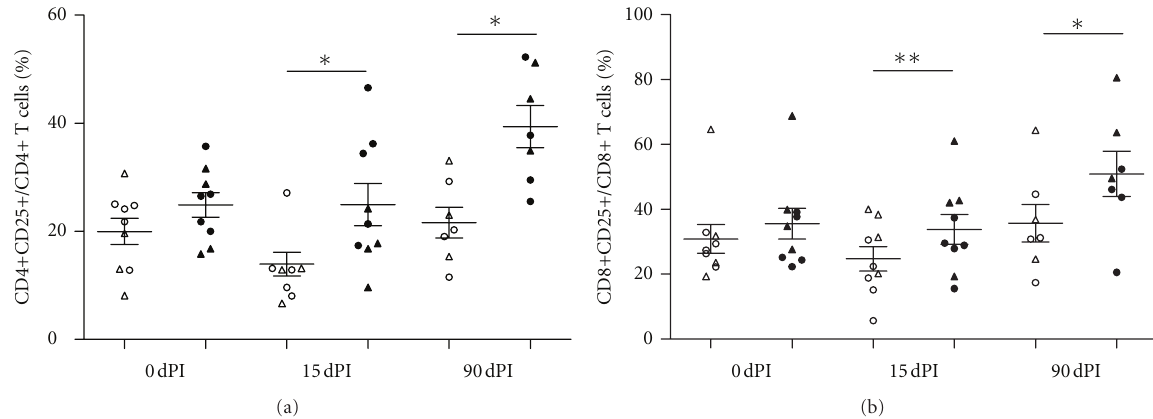
Figure 2: Percentages of lymphocyte cell subsets CD4+ (a) and CD8+ (b) expressing CD25 of PBMCs from animals inoculated with either Mb Δ mce2 ( n = 4, triangle) or NCTC 10772 ( n = 3, circle) stimulated with PPDB (black) or PBS (white) at di ff erent time points. Data were analyzed using the Wilcoxon matched pair test for cells with and without PPDB stimulation ( ∗ statistically significant P < 0 . 05 and ∗∗ statistically significant P < 0 . 01). The means ± SEM are